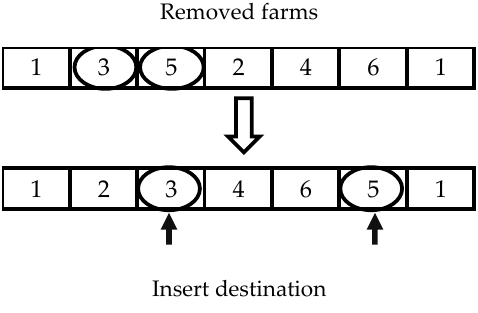
Figure 7. Example of best insertion.